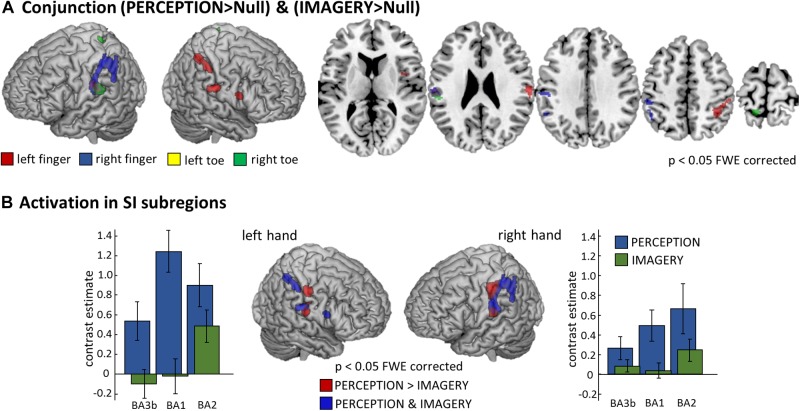
Comparison of perception and imagery. (A) Overlap in activation between perception and imagery identified by body-locus-specific conjunction analyses against conjunction null hypothesis (Friston et al., 2005), confirming that MI indeed recruits SI content-specifically. All results displayed at p < 0.05 FWE corrected at the voxel level, cluster extend threshold of 22 voxel; Note: The conjunction analysis for the right foot toe displayed also SI and SII activation however only at a threshold of p < 0.001 uncorrected, corresponding activation clusters are reported in Table 1. (B) To test what areas activate more during the PERCEPTION than during the IMAGERY condition, we computed the corresponding contrast for the left and right hand conditions and identified the hierarchically lower SI subregions (BA3b and BA1) to be stronger activated during PERCEPTION. Those SI areas that are activated in both conditions – as depicted by the conjunction analysis – are the more posterior portions of SI, corresponding to the hierarchically higher subarea BA2. To display the differences in activation level across SI subregions, we extracted first-level contrast estimates for the PERCEPTION and IMAGERY conditions contrasted against implicit baseline. These demonstrate that BA3b and BA1 do not show activation levels exceeding baseline, and that activation levels in BA2 are higher in the PERCEPTION condition than in the IMAGERY condition.